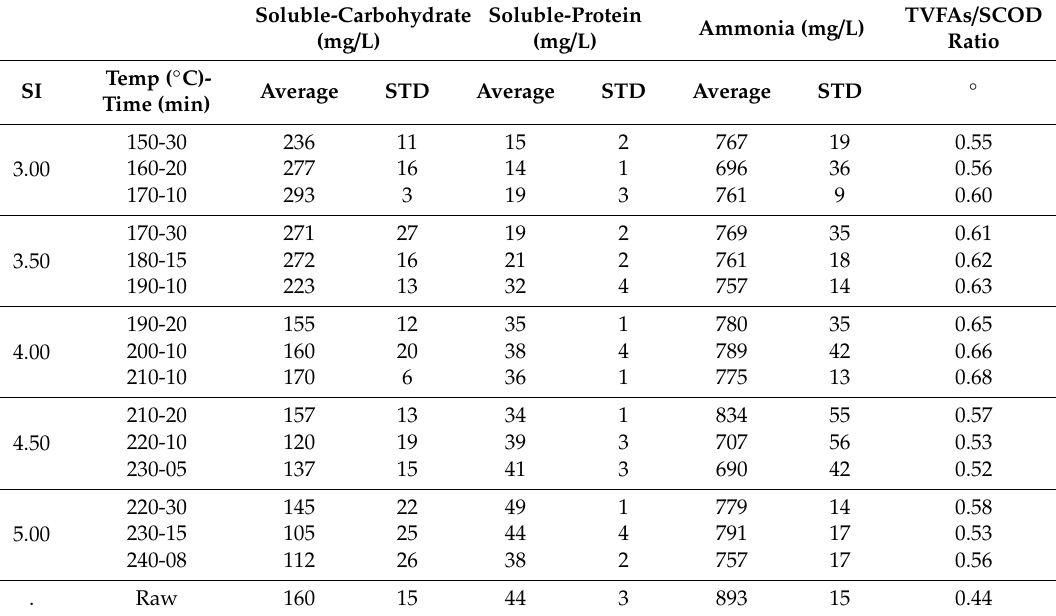
Soluble- Soluble- Ammonia Carbohydrate Protein TVFAs/SCOD (mg/L) (mg/L) (mg/L) TVFAs / SCOD Soluble-Carbohydrate Soluble-Protein Ammonia (mg / L) Ratio (mg / L) (mg / L)